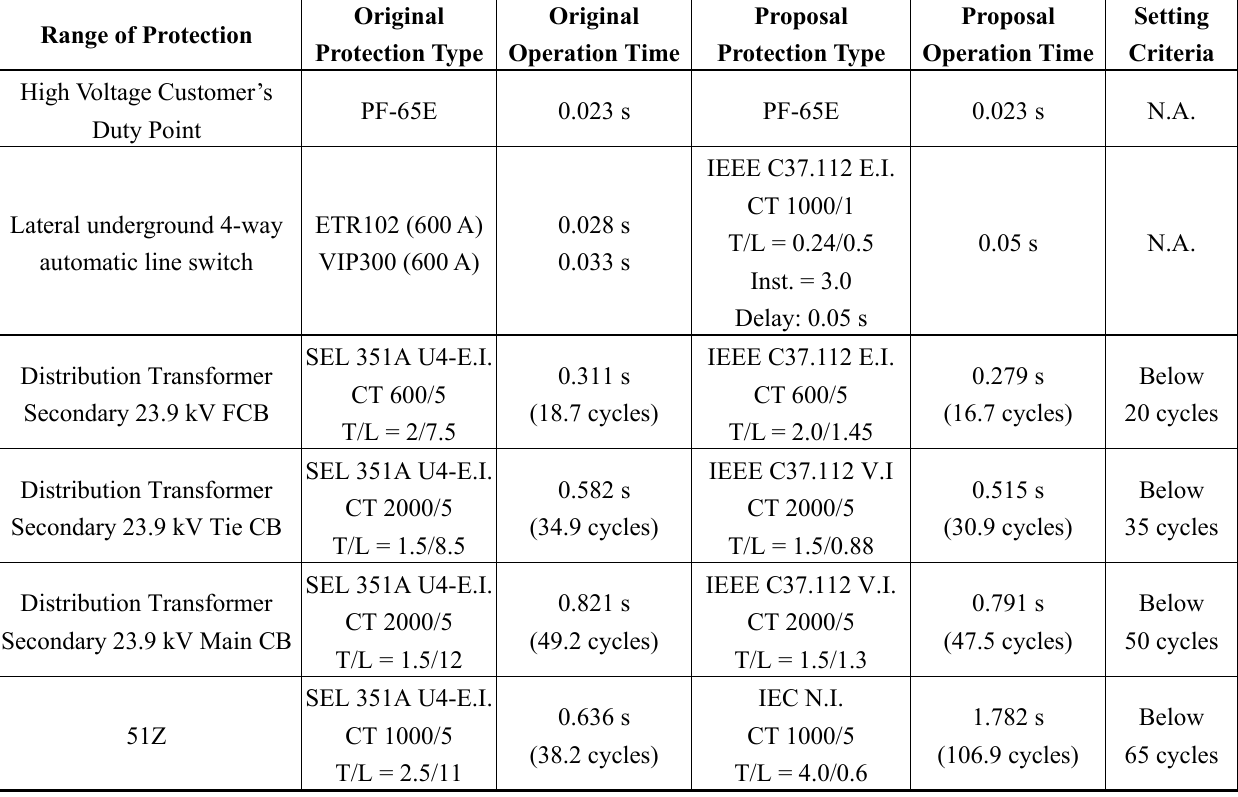
Table 5. Original and proposed LCO relays of Minsheng D/S.